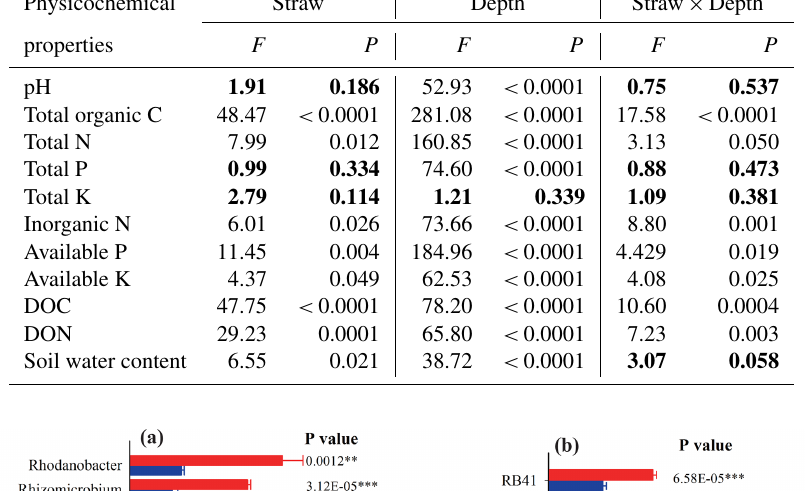
Table 1. Two-way ANOVA analysis of soil physicochemical properties at four depths under two straw management strategies, each with three replicates. The data in bold indicate soil physicochemical properties that were not affected by straw management, soil depth, or their interaction ( P > 0 . 05). DOC, dissolved organic carbon; DON, dissolved organic nitrogen.